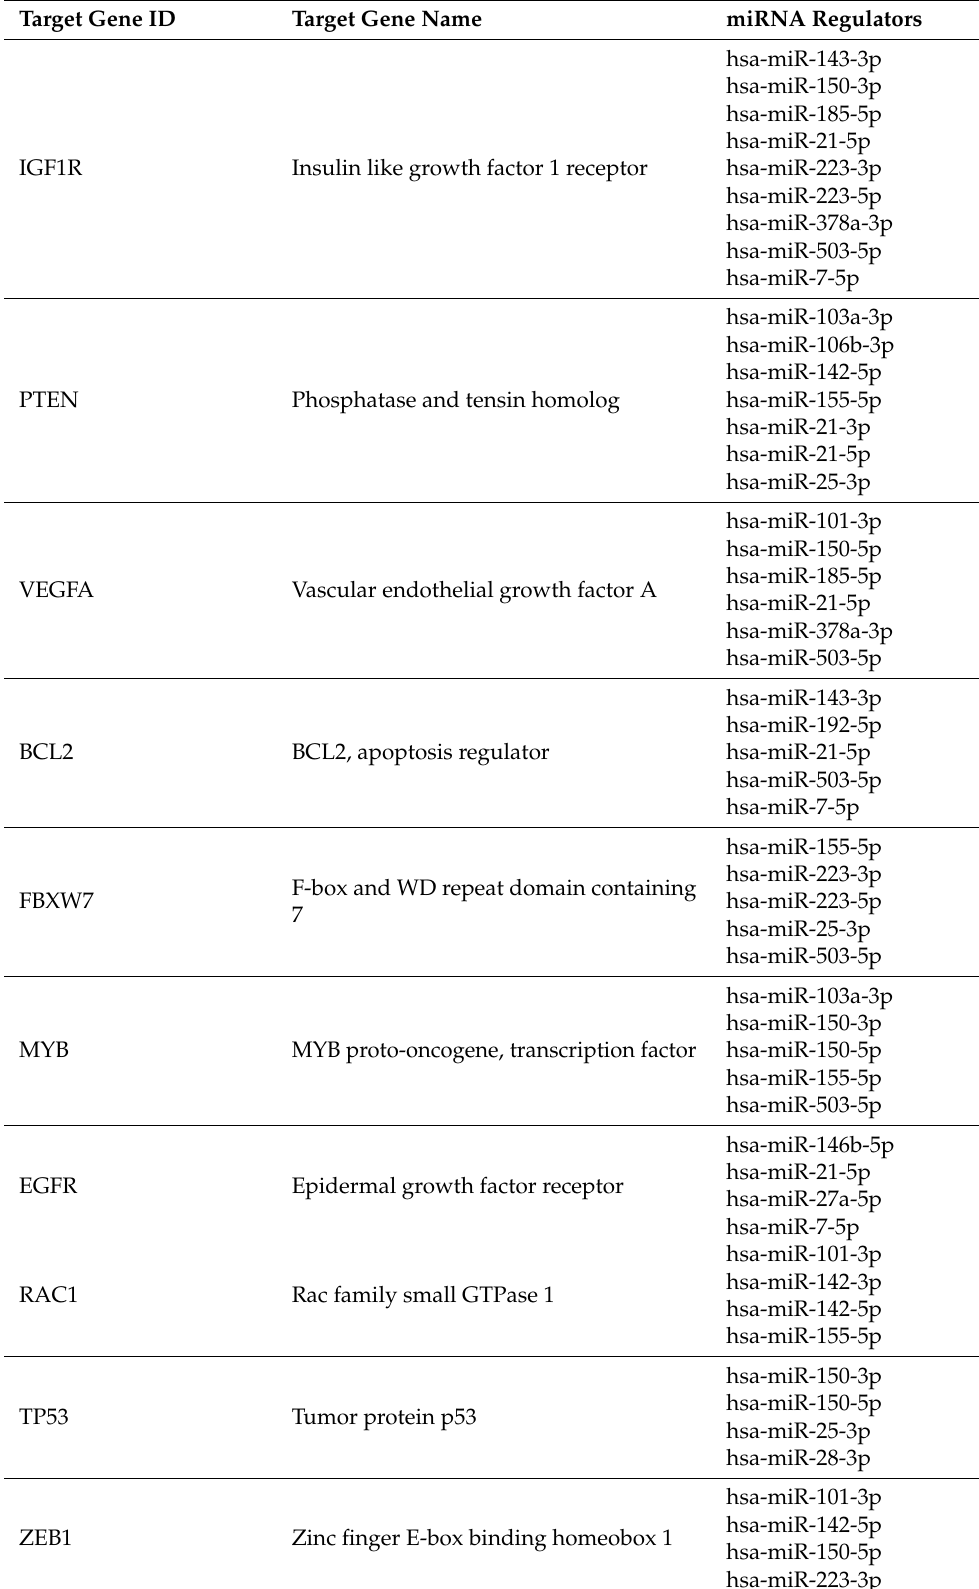
Table 5. Common targets of SF EV miRNAs found to be significantly enriched in the joints of RA patients with high-grade